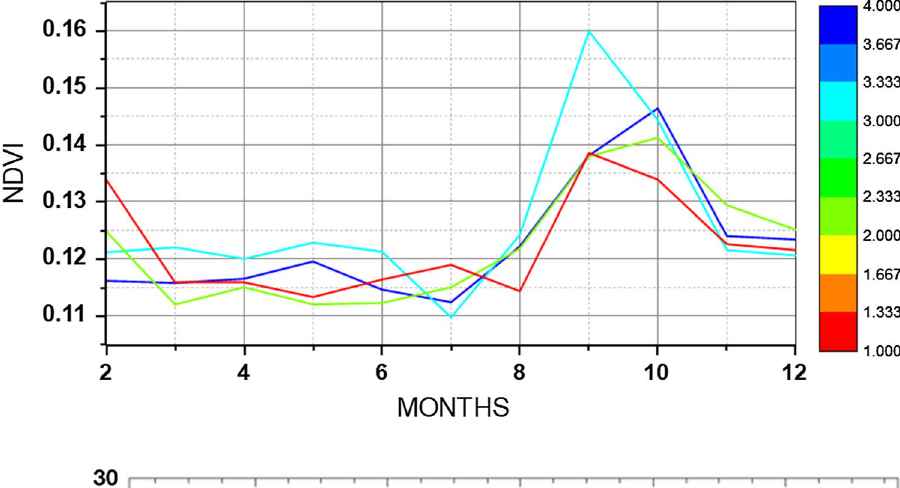
Fig. 8 a Annual temperature ( ° C) and b Annual precipitation total (mm) of Zinder from 1901 to 2017